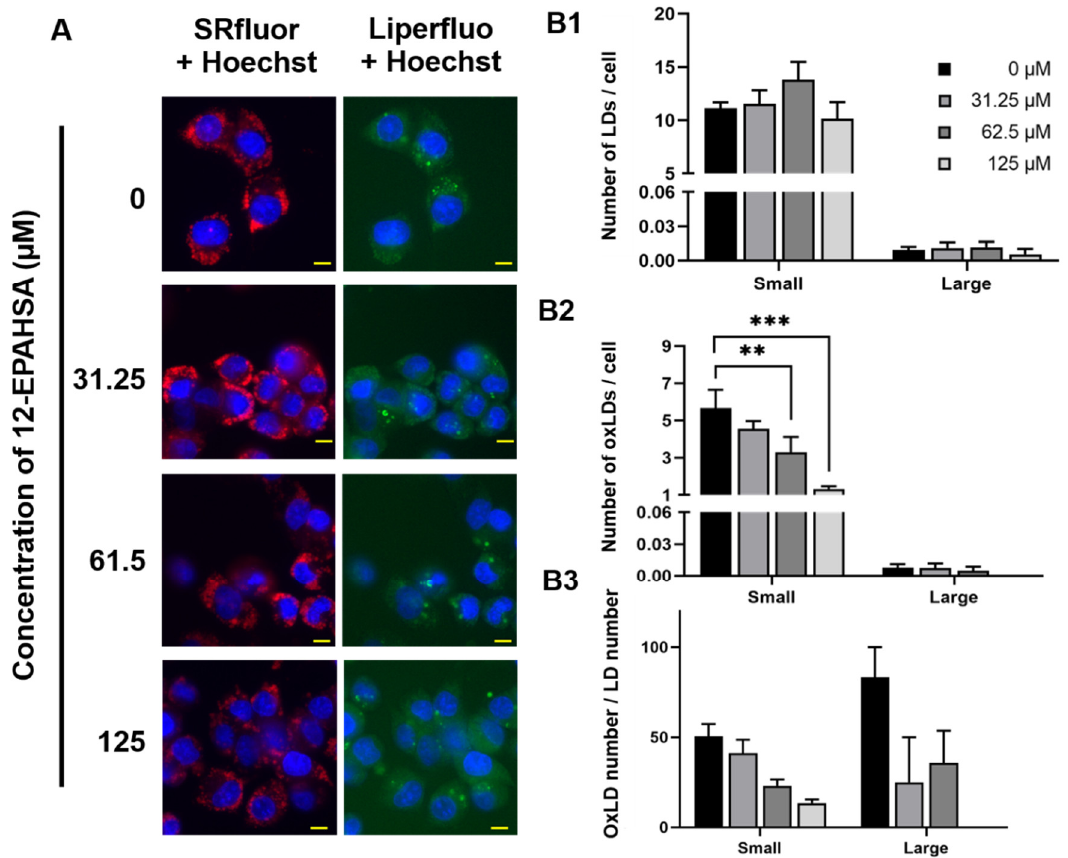
Figure 2. Effect of 12-EPAHSA on oxidation of LA-induced LDs in C3A cells. Fluorescent images showed neutral lipid (red), lipid peroxide (green) and nuclei (blue) ( A ). The scale bar shown in each image is 10 μm. To quantify the number of total LDs and oxLDs, fluorescent images were analyzed with ImageJ software. The results are presented as the number of total LDs ( B1 ), the number of oxLDs ( B2 ), and degree of oxidation ( B3 ) for small (< 3 μm 2 ) and large (≥ 3 μm 2 ) LDs. Columns and bars represent the mean ± SEM ( n = 3). ** p < 0.01, *** p < 0.001.